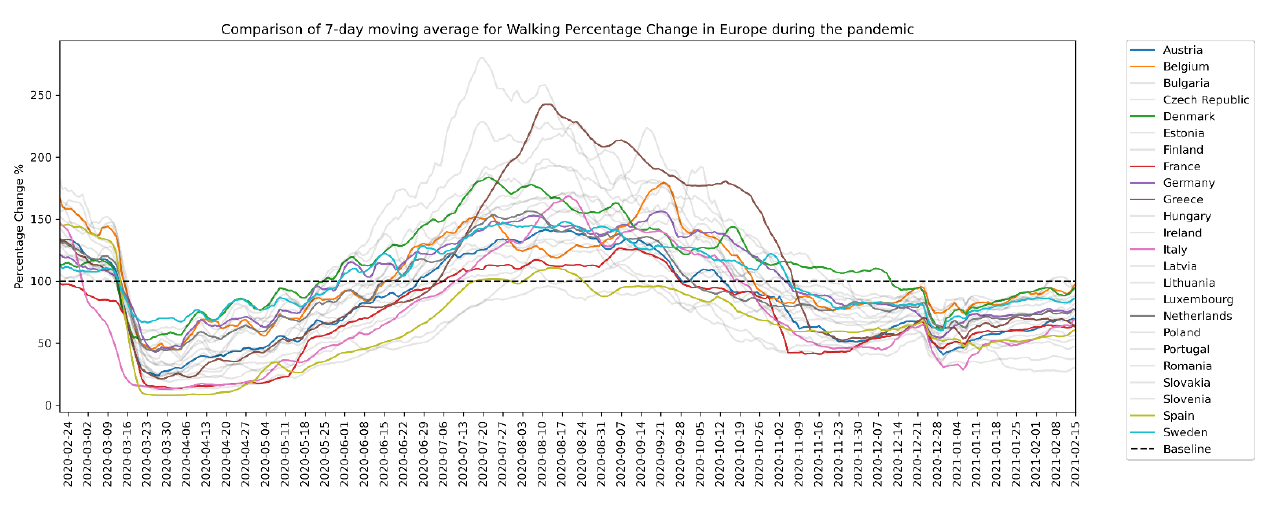
Figure 3. Comparison of 7-day moving average for walking percentage change in Europe during the pandemic (Source: